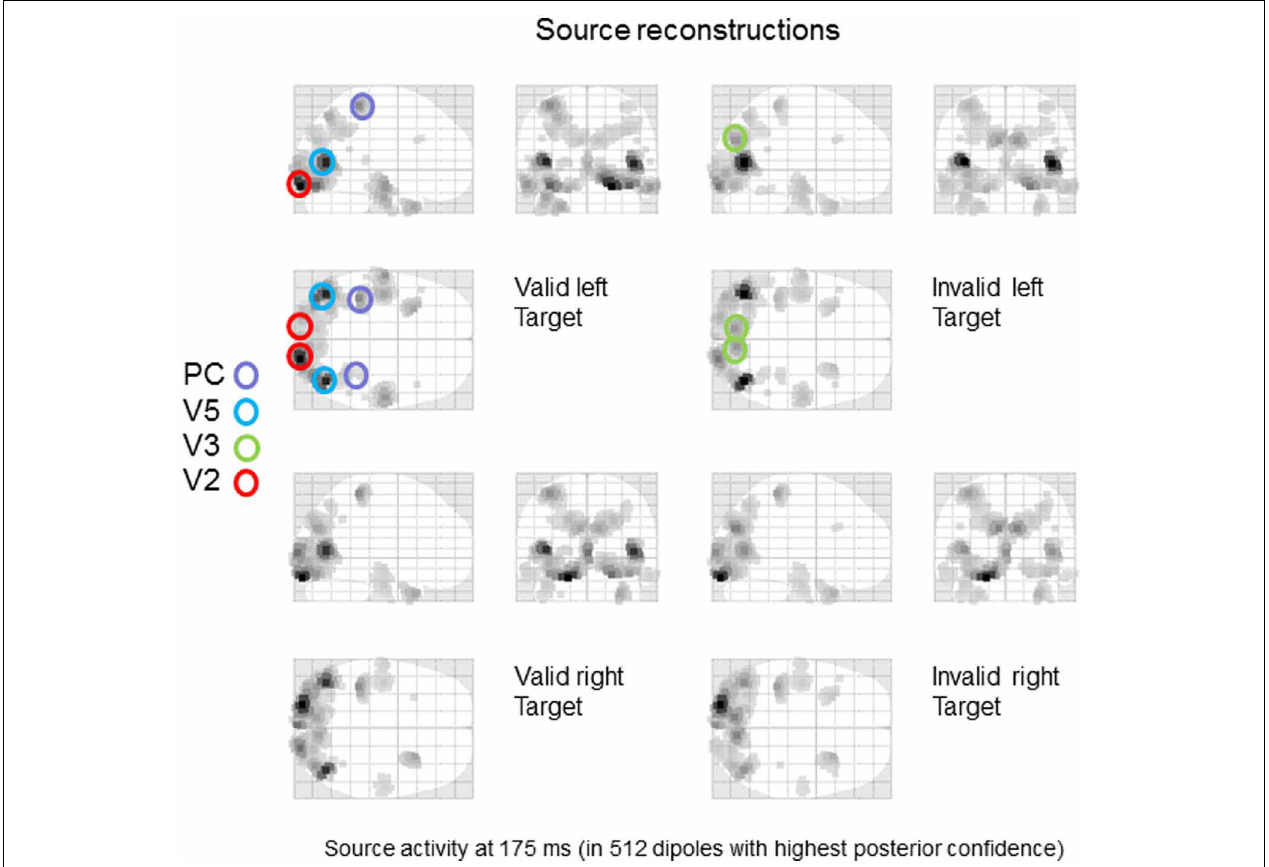
FIGURE 2 | Source specification for dynamic causal modeling. A distributed source reconstruction was performed (Mattout et al., 2006) and the power of evoked responses was quantified over the time course of the trial and all frequencies to yield the maximum intensity projections shown.